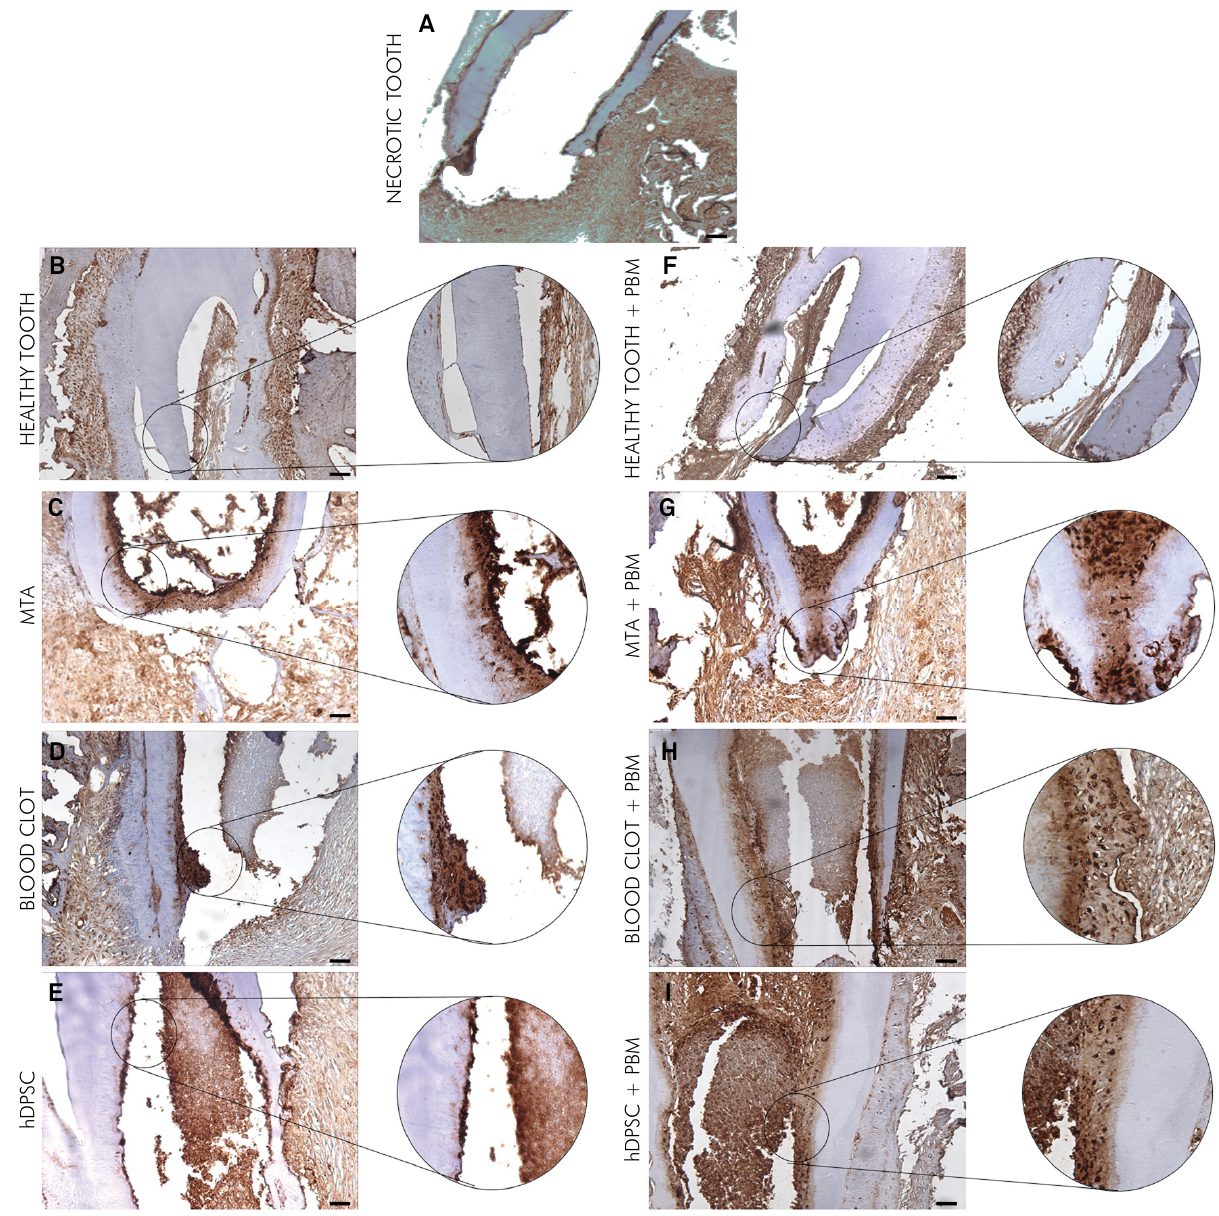
Figure 5. BSP immunoexpression of all experimental groups. Thin layer of BSP-positive dentin in the inner portion of root canal walls in the (A) necrotic tooth group (HRP, 40x magnification), (B) healthy tooth group (HRP, 40x magnification), (C) MTA group (HRP, 40x magnification), (D) blood clot group (HRP, 40x magnification), (E) hDPSC group (HRP, 40x magnification), (F) healthy tooth+PBM group (HRP, 40x magnification). Presence of a thicker layer of BSP-positive dentin on root canal walls in the (G) MTA+PBM